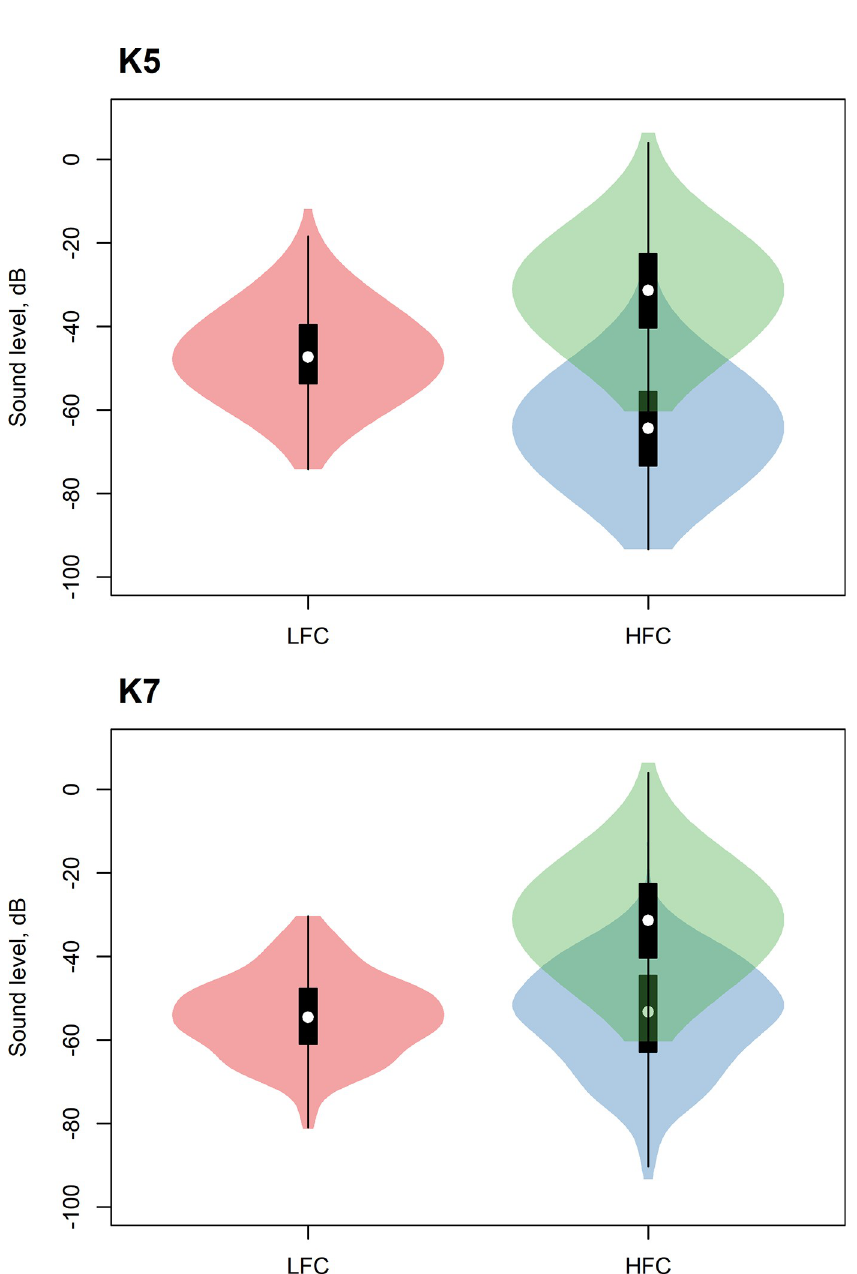
Fig 3. Measured amplitude in the middle of the lower-frequency component (LFC, red) and in the middle of the higher-frequency component (HFC, blue) of K5 (top) and K7 (bottom) calls. Green identify measurements of the higher-frequency component adjusted by killer whale